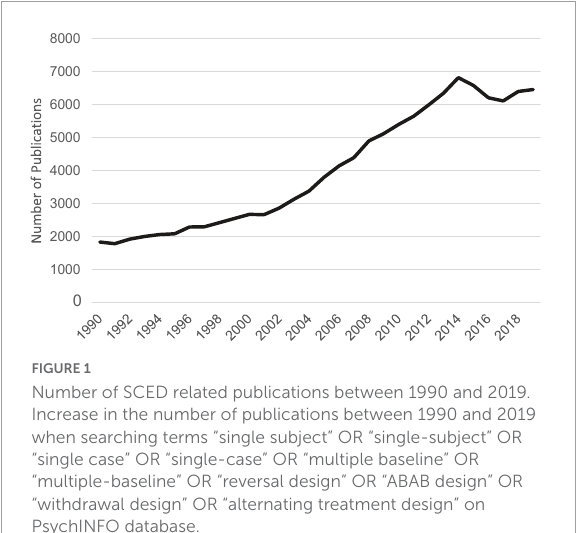
FIGURE1 Number of SCED related publications between 1990 and 2019. Increase in the number of publications between 1990 and 2019 when searching terms “single subject” OR “single-subject” OR “single case” OR “single-case” OR “multiple baseline” OR “multiple-baseline” OR “reversal design” OR “ABAB design” OR “withdrawal design” OR “alternating treatment design” on PsychINFO